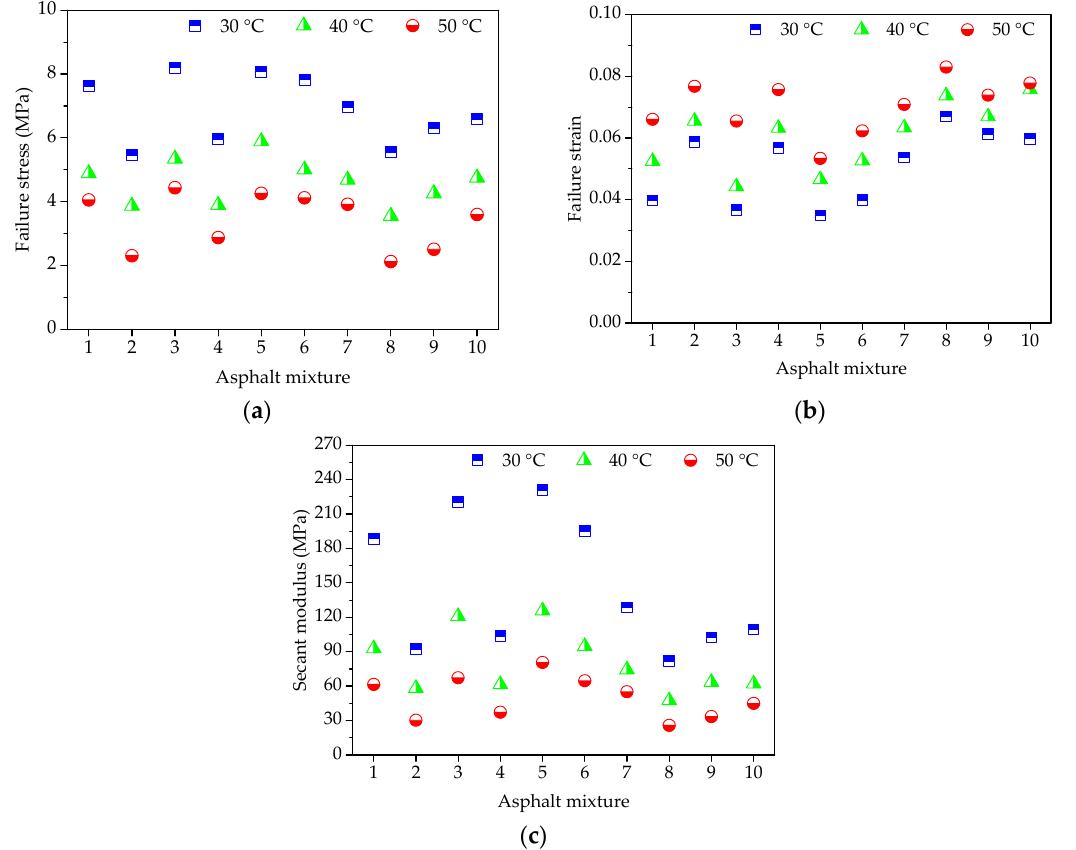
Figure 9. Failure results of asphalt mixtures: ( a ) Failure stress; ( b ) Failure strain; and, ( c ) Secant modulus.